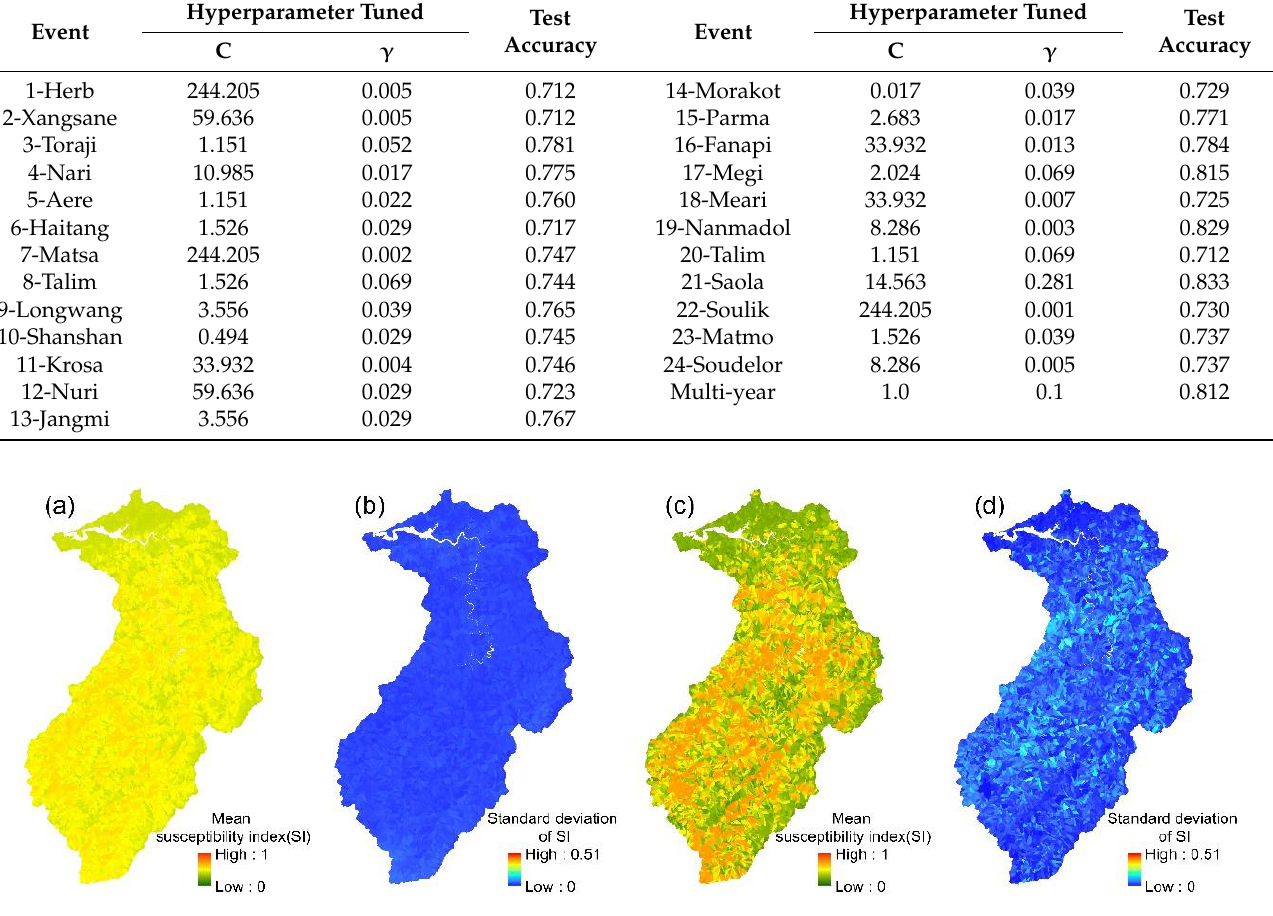
Figure 7. KLR models: ( a , b ) the mean susceptibility index and standard deviation of 24 event-based models; ( c , d ) the mean susceptibility index and standard deviation of the multi-year model.